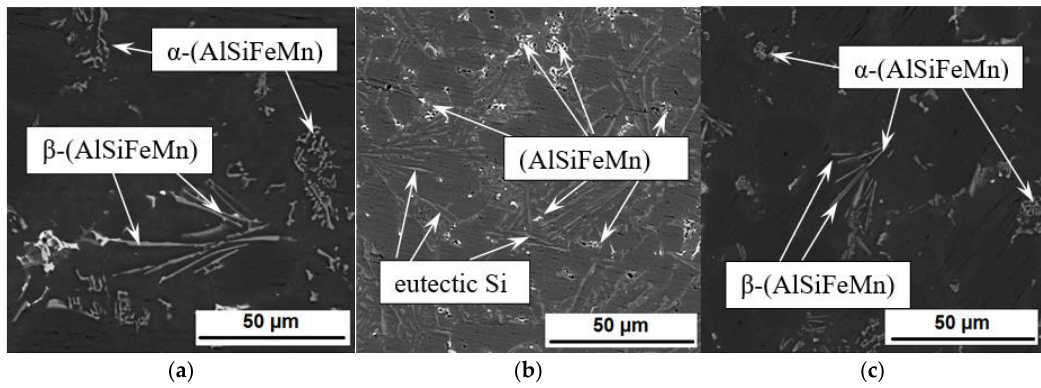
Figure 3. SEM-images of Al-12%Si alloys in mode of backscattered electrons: initial state (0 mass % of W), ( a ); 0.01 mass % of W ( b ); 0.1 mass % of W, ( c ).